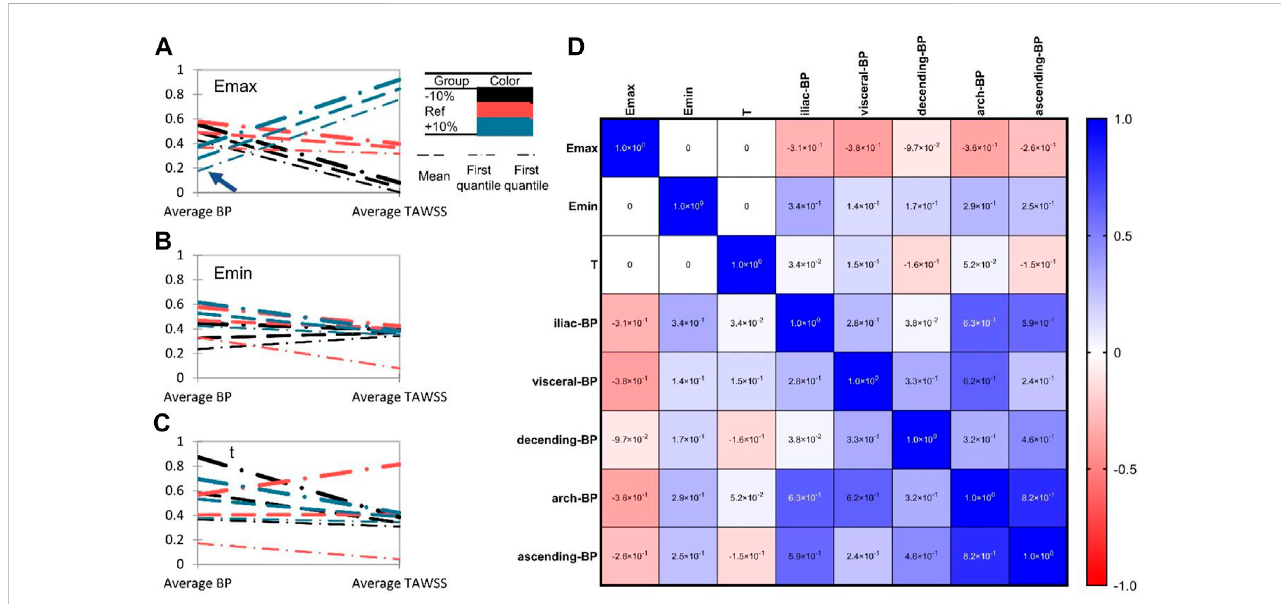
FIGURE 5 Heart function alteration and change of thrombosis or TAWSS at different aortic parts. (A – C) . Parallel coordinate charts of BP concentration and TAWSS classi fi edbyheartfunction(E max ,E min ,Trangesfrom+10%to − 10%comparedwiththereferencestate).BPconcentrationandTAWSS(Pa)havebeenrescaled rangesfrom0to1.Thearrowheadin (A) indicatesthesigni fi cantroleofE max onthrombusformation. (D) Multiplecorrespondenceanalysis(MCA)ofE max ,E min , T, and BP concentration in different aortic